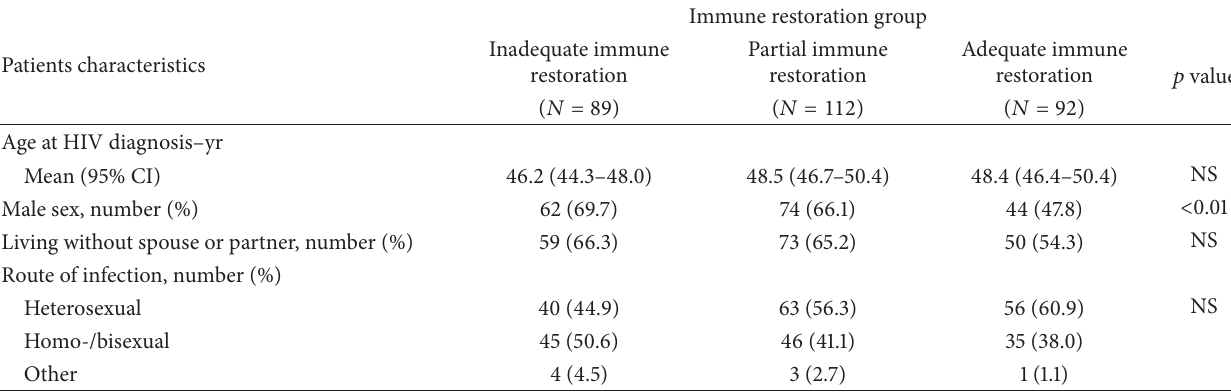
Table 1: Characteristics of HIV patients under stable, suppressive antiretroviral therapy, according to pattern of immune restoration.